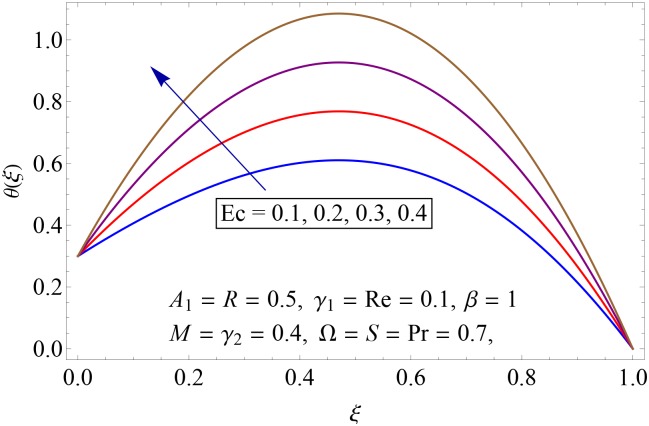
Impact of Ec on θ(ξ).